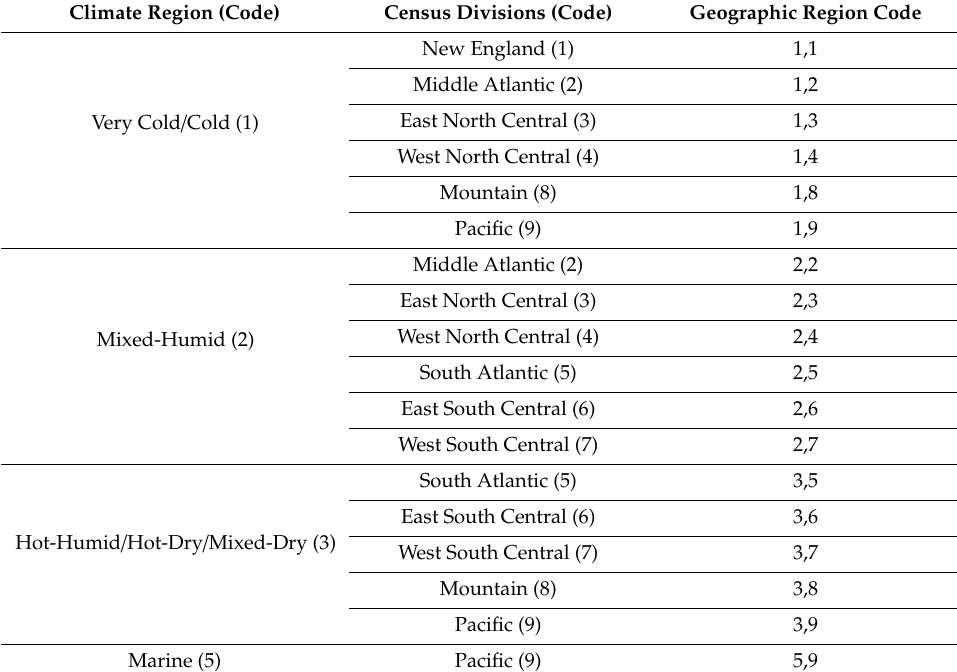
Table 3. Coding scheme for geographic